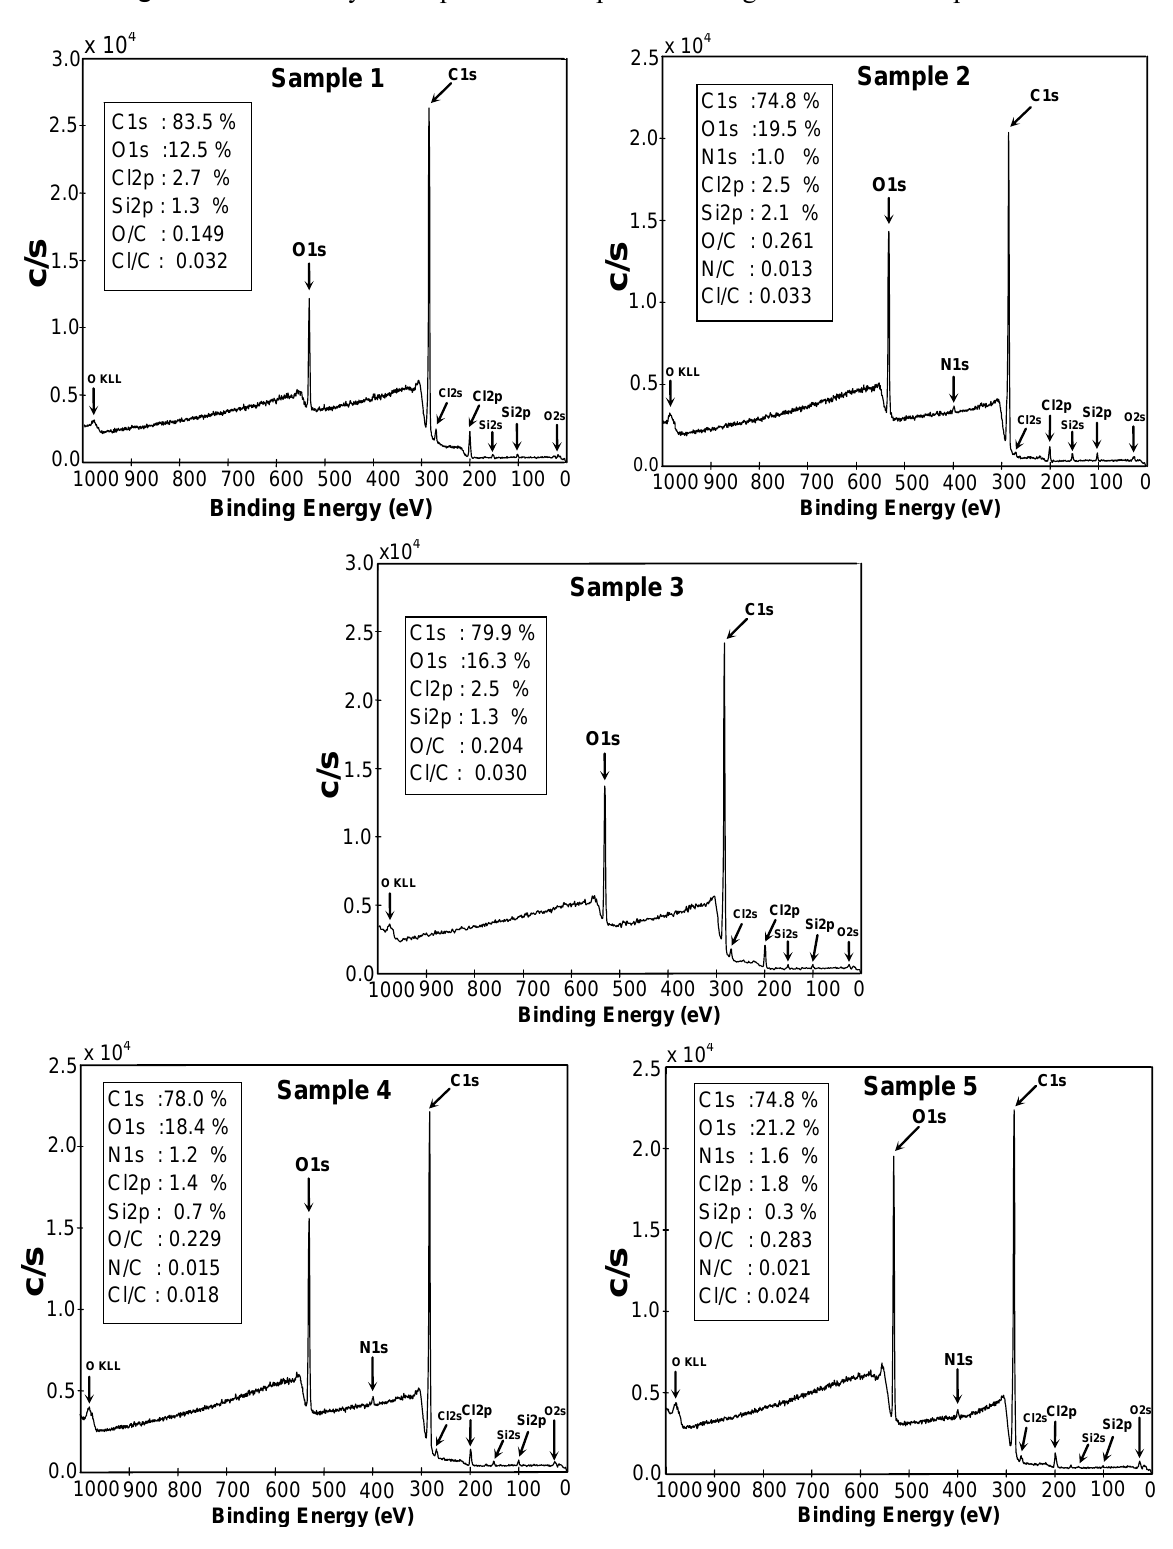
Figure 4. XPS survey-scan spectra of Samples 1-5 along with atomic